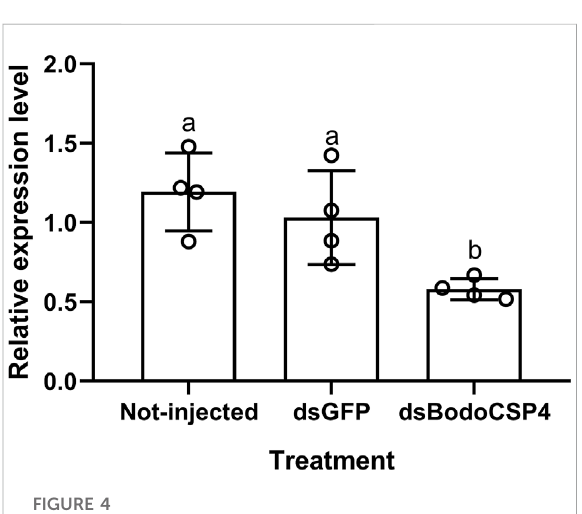
FIGURE 4 Effects of treatment of Bradysia odoriphaga male adults with dsGFP or dsBodoCSP4 on their mRNA levels of BodoCSP4 (as determined by RT-qPCR). The values are means ± SEM; means with different letters are signi fi cantly different ( p <